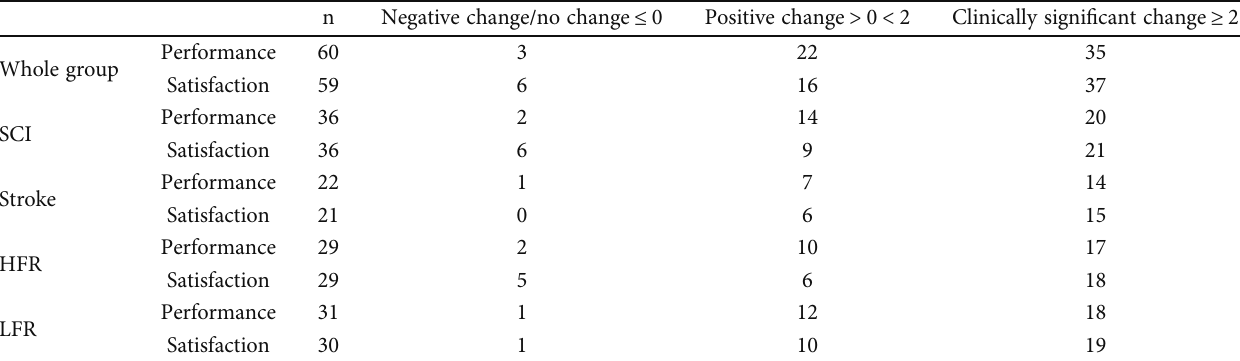
Table 3: Change in COPM performance and satisfaction from baseline to follow-up (12 months) dichotomized into groups based on degree of change.